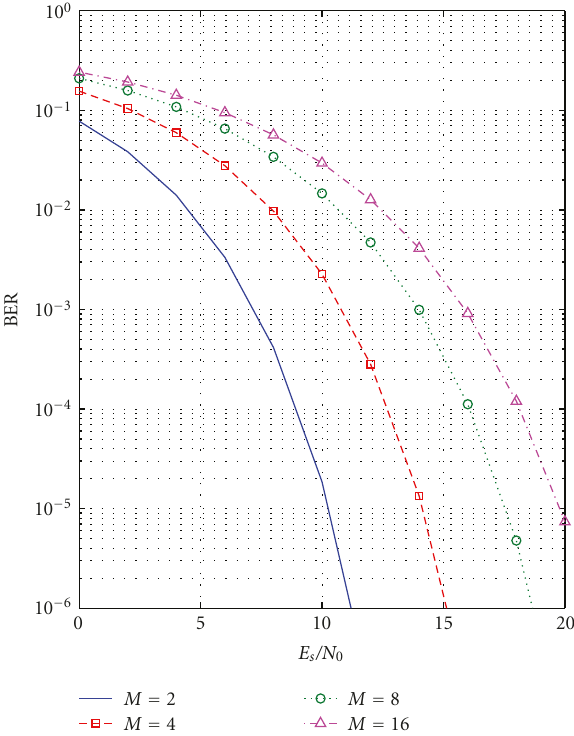
Figure 15: BER performance of the new modulation scheme for di ff erent modulation orders with using the experimental results of measurement campaign